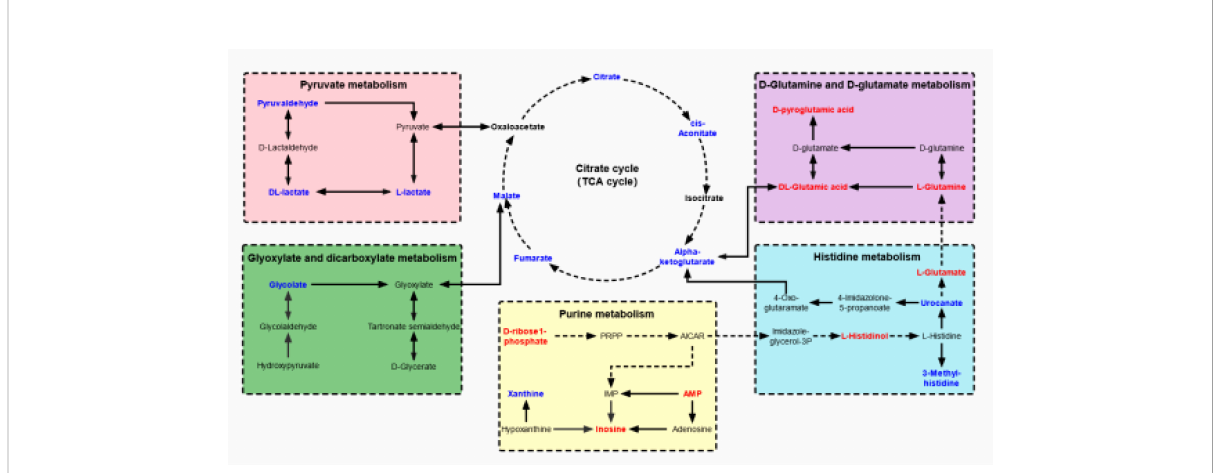
FIGURE 5 The network of altered metabolic pathways in response to aging-induced kidney dysfunction in mice. The upregulated metabolites are labeled with red and the downregulated metabolites are labeled with